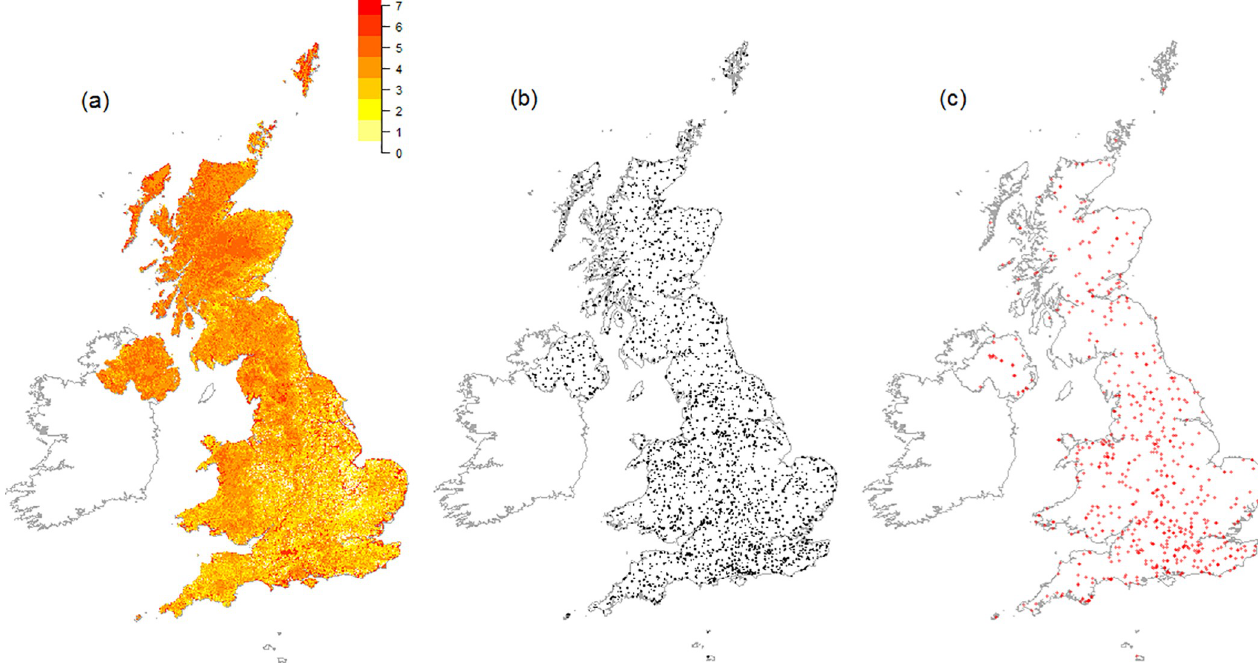
Fig 2. Land cover weightings, released monads, and surveyed monads to 2016. (a) The distribution of monad weights across Britain and Northern Ireland (weights were natural log transformed for visualisation, the colour gradient legend gives these transformed weights); (b) the monads that have been released for survey up to the end of 2016; (c) monads surveyed by volunteers in 2015 and